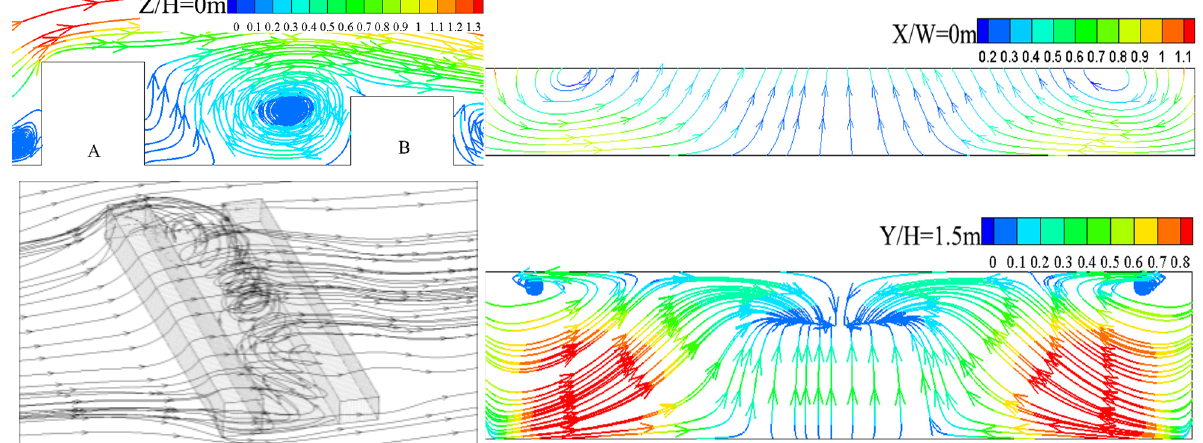
Figure 12. Plane streamline diagram and 3D flow field diagram in a decreasing street canyon with ASF = 3/2.